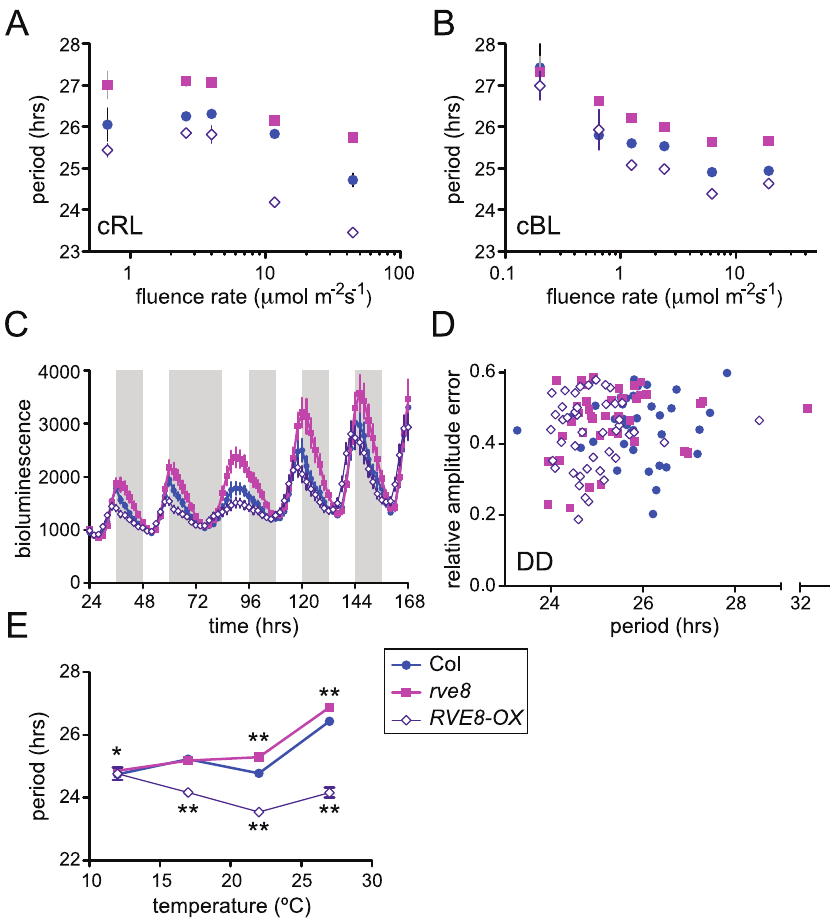
Figure 7. RVE8 clock function is both light- and temperature-dependent. Seedlings were entrained in 12 hr light:12 hr dark for 6 days at 22 u C before being analyzed for CCR2::LUC activity in different environmental conditions. (A–B) Plants were transferred to constant red (A) or blue (B) light of the indicated fluence rates; average free-running period at each fluence rate, 6 SEM is indicated. (C) Plants were maintained in the same light/ dark regimen as during entrainment and then subjected to one long night before resumption of light/dark cycles. Average luciferase activity, 6 SEM, is depicted. White bars represent times lights were on and grey bars times lights were off during imaging. (D) After entrainment, plants were transferred to continuous darkness. The average free-running periods were: Col=25.87 6 0.14 hr; rve8-1 =25.42 6 0.22 hr; RVE8-OX =24.94 6 0.12 hr. The average period of RVE8-OX , but not rve8-1 plants, was significantly different from Col (p=0.000002 and p=0.10, respectively). (E) Seedlings were released to constant red light at the indicated temperatures; free-running period 6 SEM is shown. (* indicates p , 0.05; ** indicates p , 0.001; Student’s two-tail heteroscedastic t test used for all comparisons). These data are representative of at least two independent experiments. Note that in many cases the error bars are smaller than the symbols in the